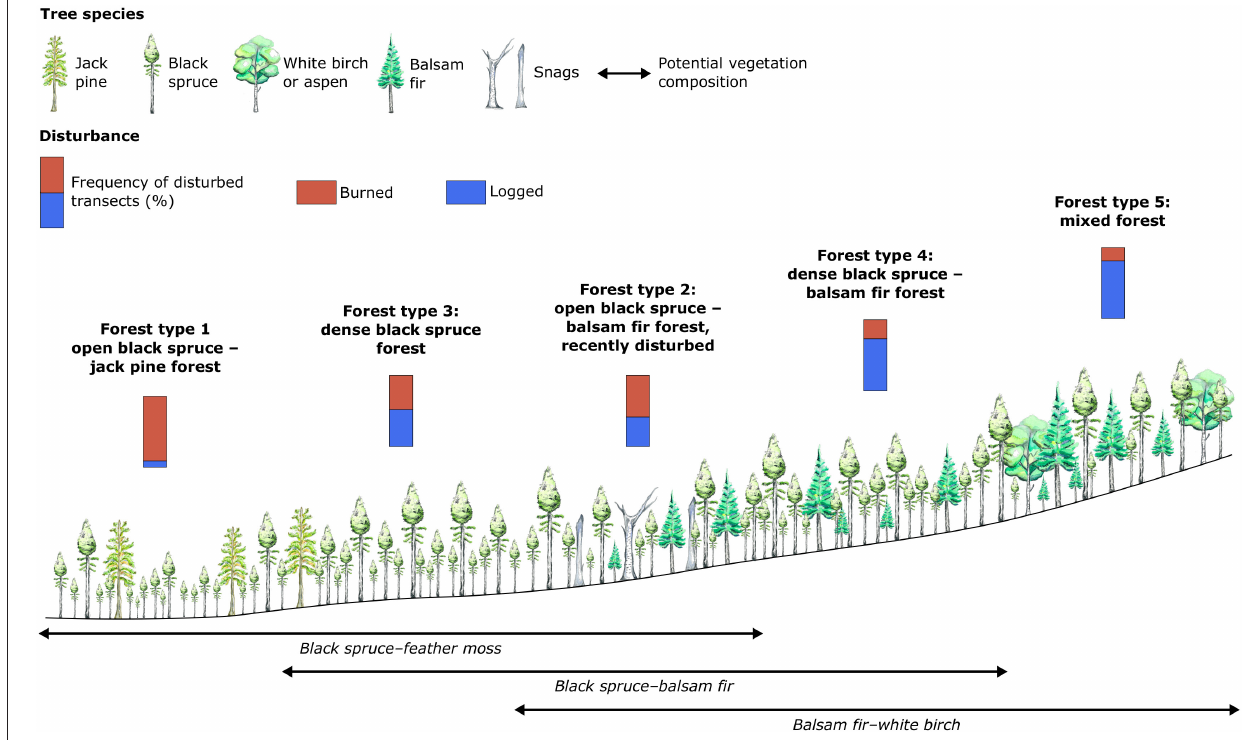
FIGURE 7 | Conceptual model of the impact of fire and logging on the different forest types identified, distributed along a potential vegetation composition, and topographic gradient. Water color paintings by Valentina Buttò.